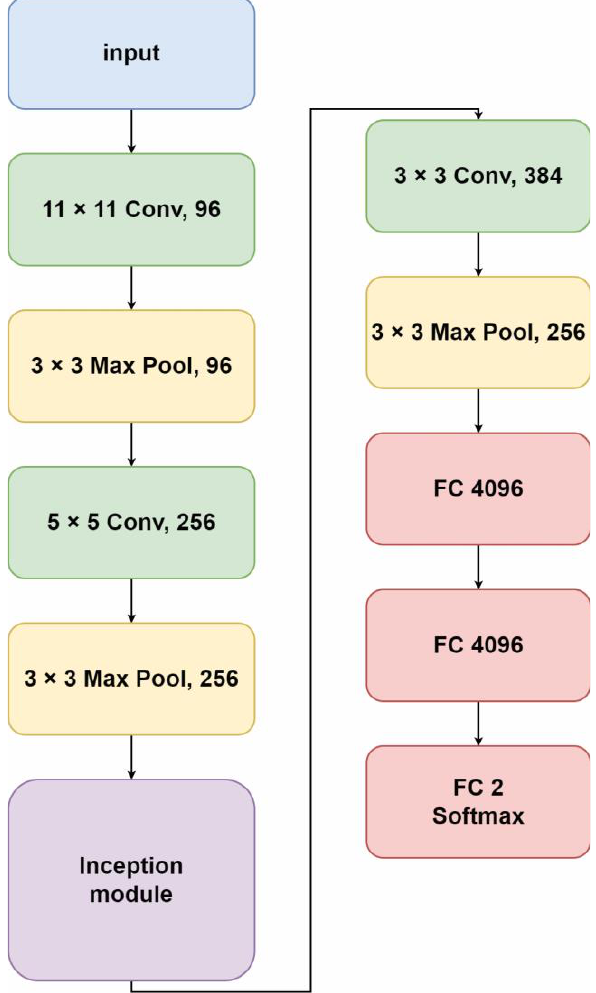
Figure 10. Proposed architecture.